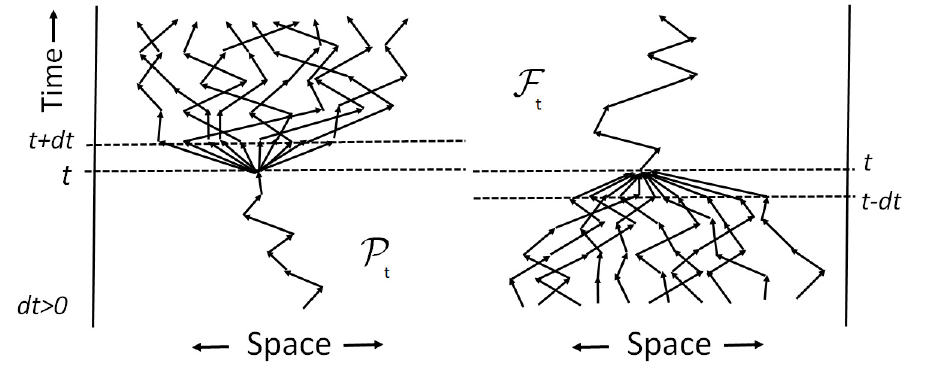
Figure 2. The ensembles of trajectories fixing P t and F t shown in the left and right panels,